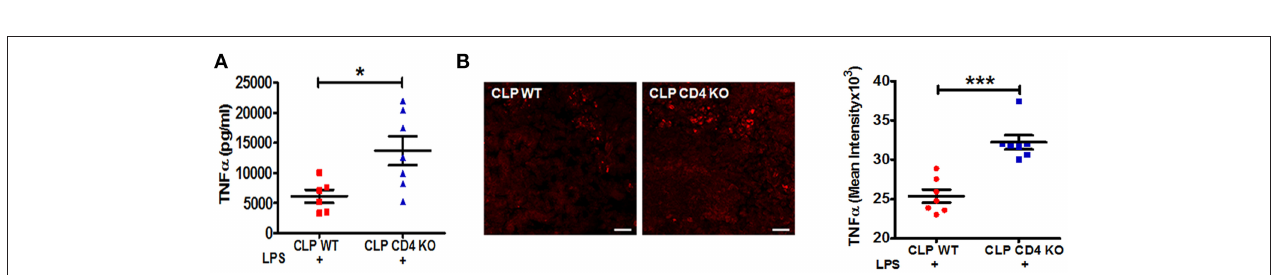
FIGURE 3 | CD4T cell-deficiency restores LPS-induced TNF α responses in CLP-survivors. To identify the role of CD4 + T cells in mediating inflammatory reflex, C57BL6/J WT and CD4 knockout mice were subjected to CLP surgery, allowed to recover for 4 weeks, and then challenged with LPS by intraperitoneal injection (6 mg/kg). Blood and spleens were harvested 90min after LPS administration. Serum TNF α was measured by ELISA. (A) Enhanced LPS-induced serum levels of TNF α in endotoxemic CD4T cell-deficient CLP-surviving mice. Results represent the mean ± SEM of 6–7 mice per group from one of two independent experiments; CLP WT + LPS vs. CLP CD4 KO + LPS * p < 0.05. (Mann-Whitney U -test). (B) TNF α staining in spleen sections of CLP WT and CLP CD4 KO. Magnification (20X; scale bar = 50 µ m). Images are representative of spleen sections from two independent experiments ( n = 7). CLP WT + LPS vs. CLP CD4 KO + LPS *** p < 0.001. (Mann-Whitney U